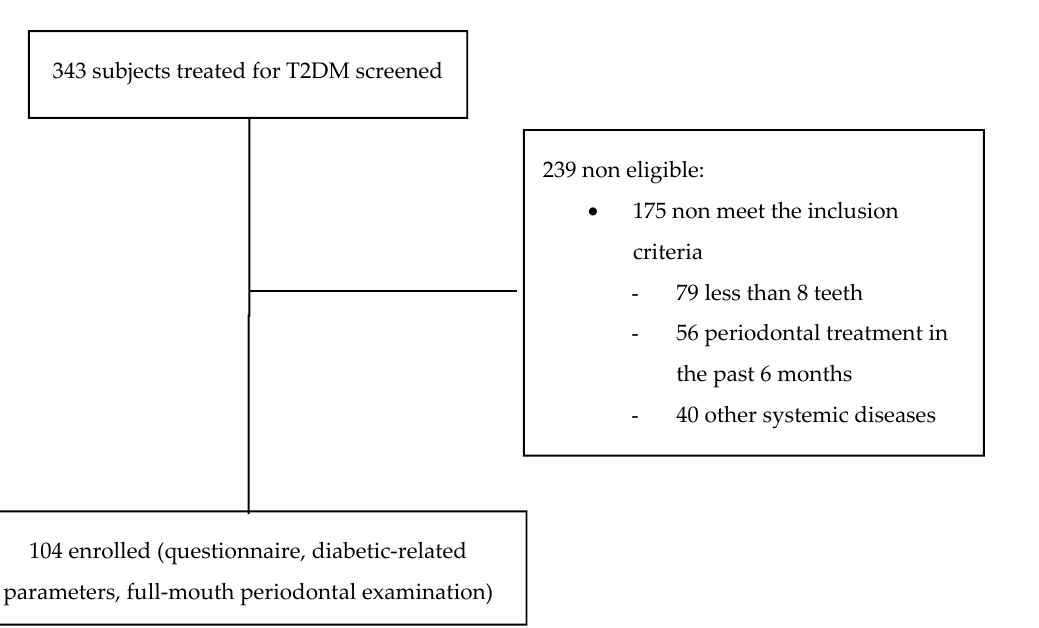
Figure 1. Subject recruitment and